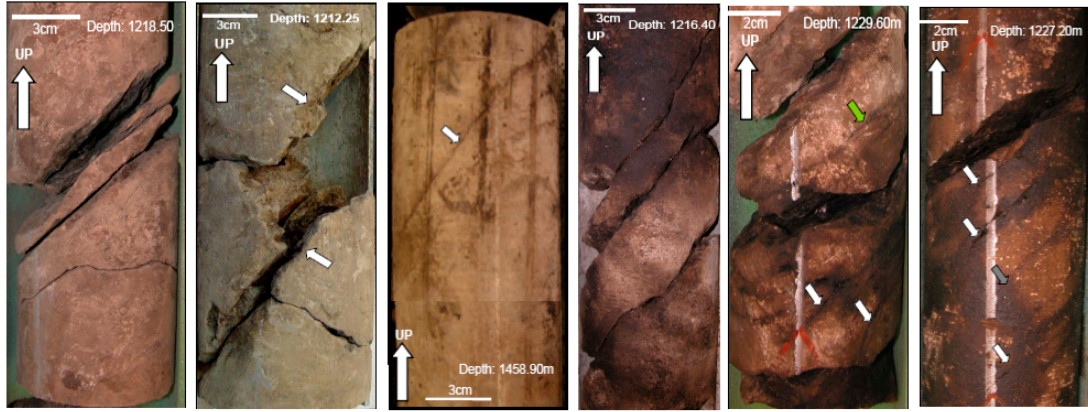
Figure 5. Sub-vertical fractures and vugs some infilled with heavy oil in core samples taken from the Kuh-e-Mond heavy oil field.